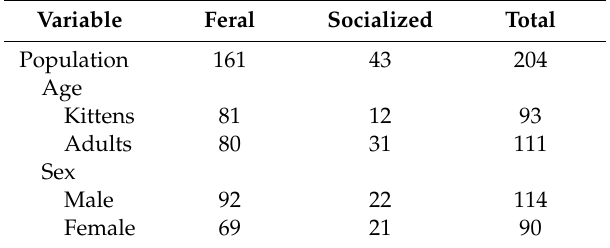
Table 1. Characteristics of 204 free-roaming cats at inclusion in a trap-neuter-return (TNR) program. Variable Feral Socialized